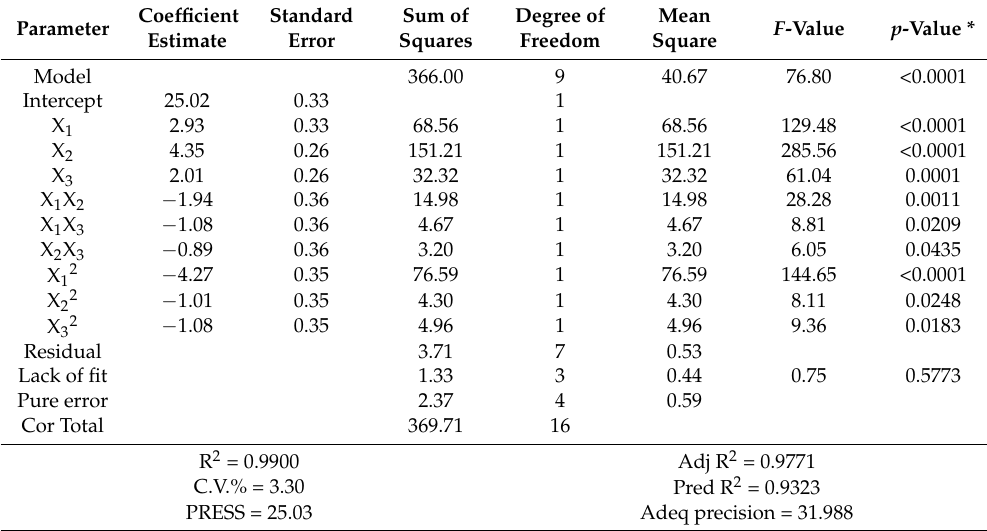
Table 2. Analysis of variance (ANOVA) for the regression model.